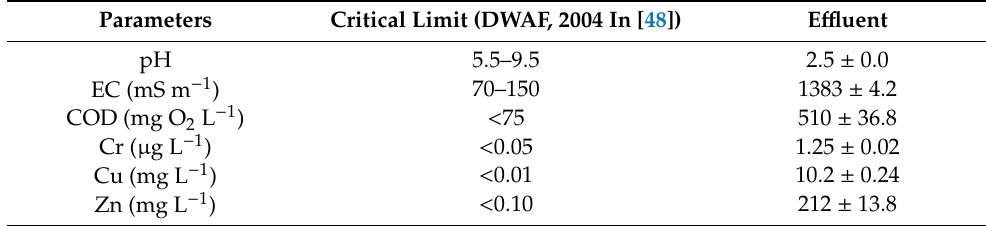
Table 8. Electrical conductivity, pH and concentrations of heavy metals in the e ffl uent used. Parameters